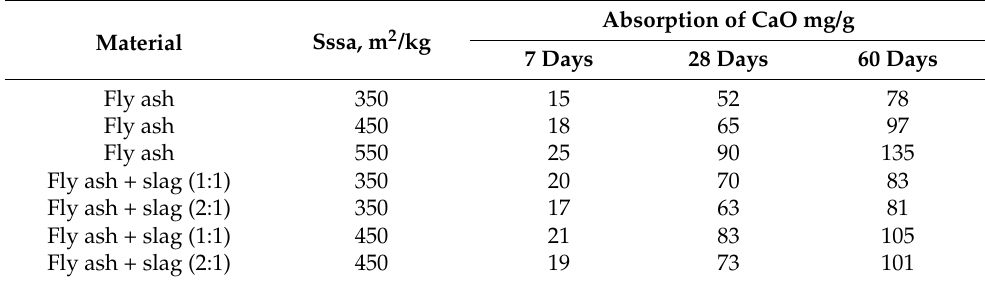
Table 1. Pozzolanic activity of fly ash and ash of slag composition.